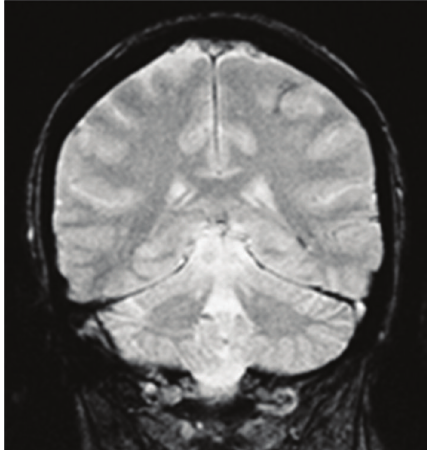
Figure 5: Third case of isolated central sulcus hemorrhage. Gradient echo MR images in a 50-year-old female with history of renal transplant and presenting with left leg weakness demonstrated signal loss within the left central sulcus consistent with an isolated hemorrhage. Associated nonspecific white matter changes were also seen. Angiographic work up was without any evidence of aneurysms or vascular malformations. Although the age of the patient and absence of other areas of chronic hemorrhage on MR imaging make this an atypical presentation, findings of an isolated central sulcus hemorrhage in a normotensive patient without other etiologies accounting for that hemorrhage would suggest a possible diagnosis of